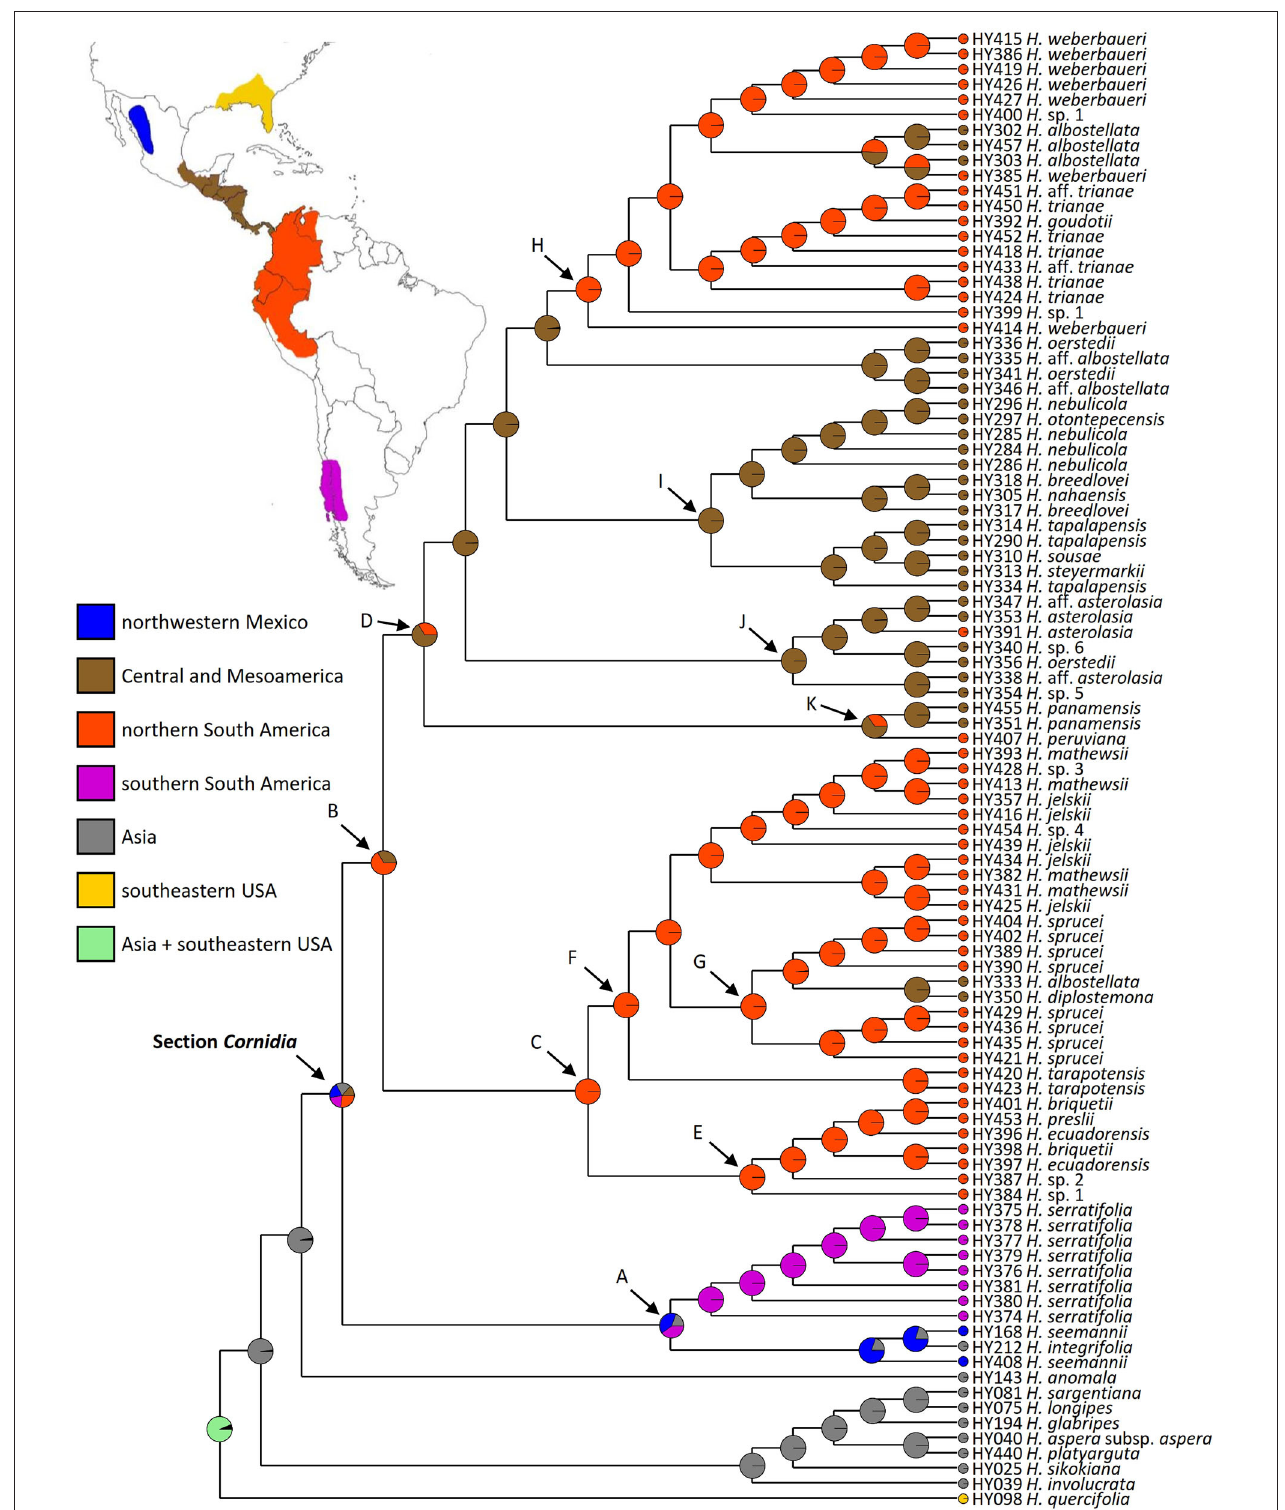
FIGURE 6 | Ancestral area reconstruction analysis in BioGeoBEARS for Hydrangea section Cornidia under the Dispersal–Vicariance Analysis with long-distance dispersal (DIVA + J) model.